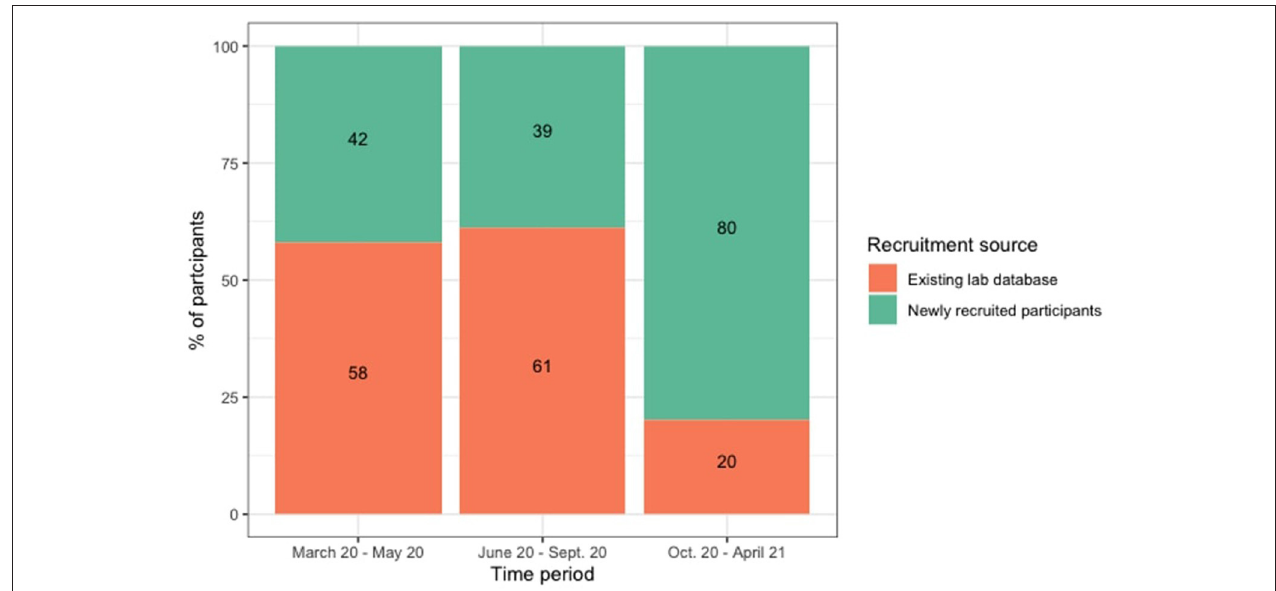
FIGURE 3 | Turnover from old to new participants over the course of the pandemic year. Percentage of participants from our pre-pandemic lad database (orange) and newly recruited participants (green) for each period of assessment (left: March 2020 to May 2020, center: June 2020 to September 2020, right October 2020 to April